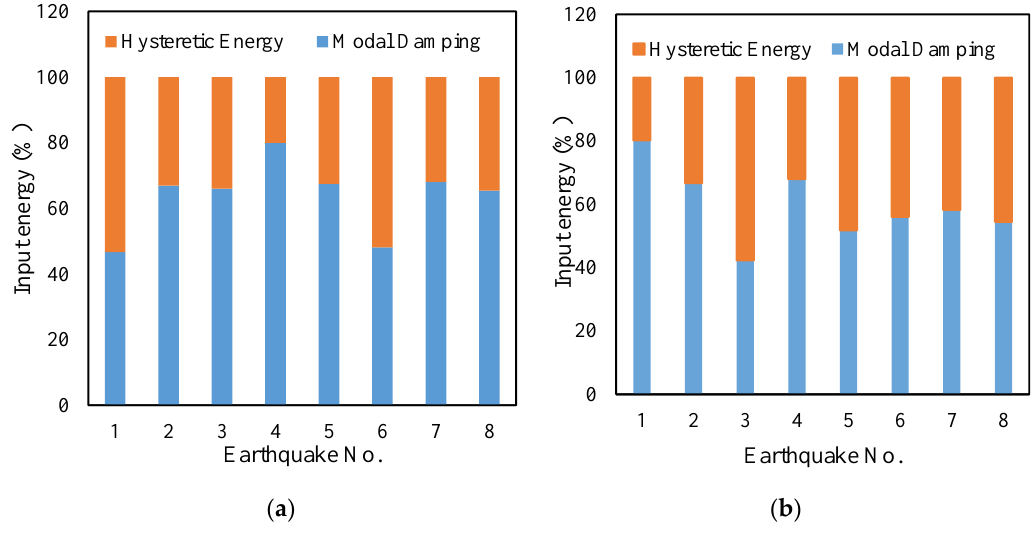
Figure 13. Percentage of input energy dissipated by modal damping and hysteretic dissipation. ( a ) Near-field earthquakes; ( b ) Far-field earthquakes.